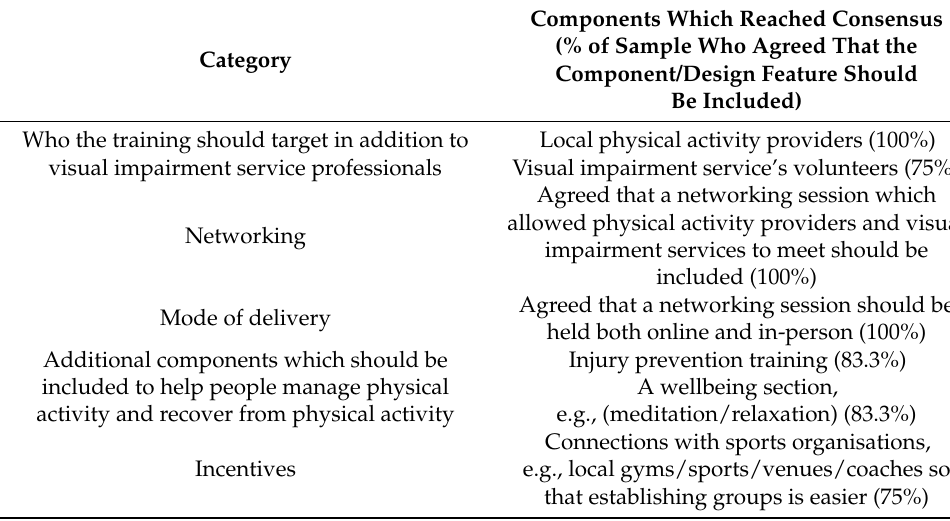
Table 3. Components which reached consensus in round